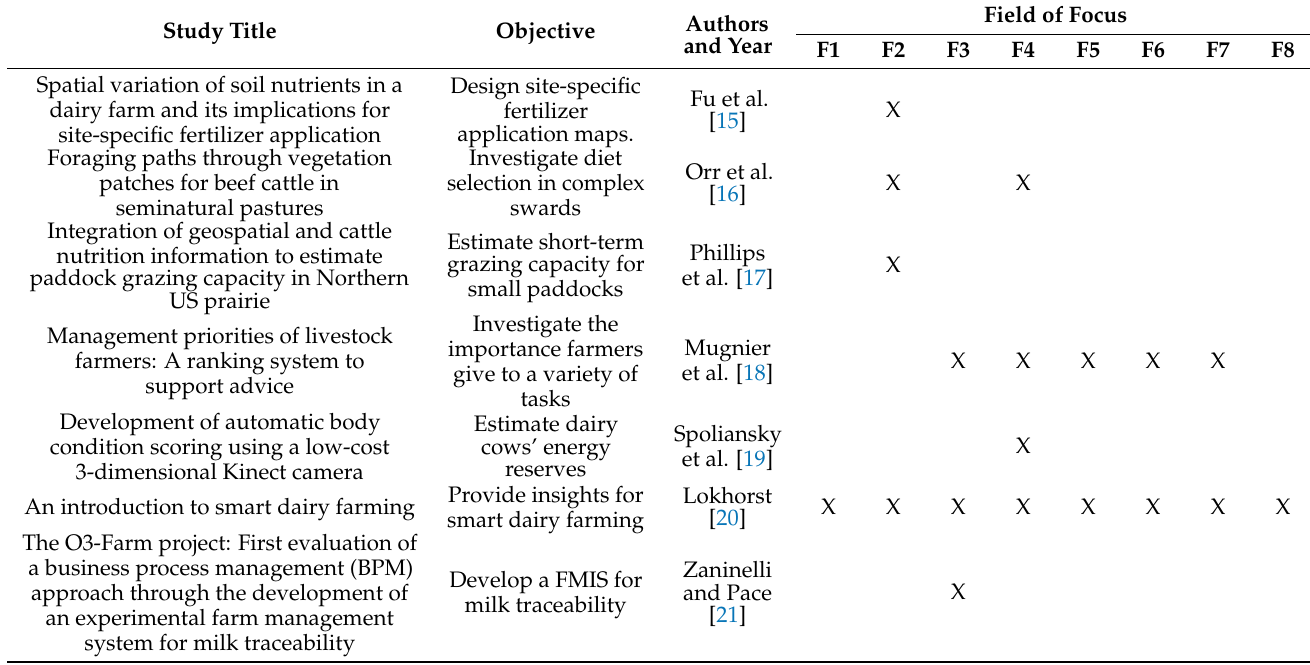
Table 5. Studies that were used to answer research question 1, together with their field of